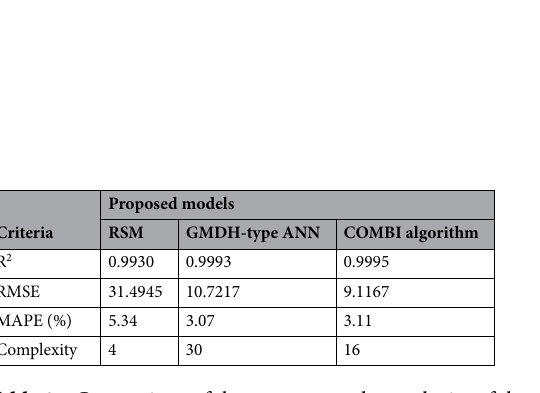
Table 8. Comparison of the accuracy and complexity of the proposed